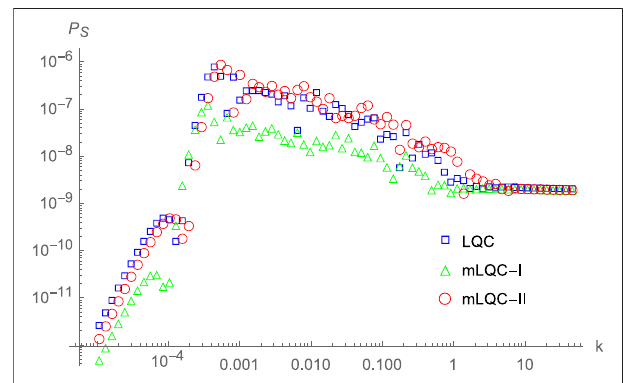
FIGURE 11 | The primordial power spectra of the cosmological scalar perturbations in the hybrid approach with the Starobinsky potential, respectively, for LQC, mLQC-I, and mLQC-II. The mass of the in fl aton fi eld is set to 2 . 44 × 10 − 6 m pl . The background evolution is chosen so that the pivot mode is k * (cid:2) 5 . 15 in all three models. The initial states are the second- orderadiabaticstatesimposed inthecontractingphaseatthemoment t 0 with t 0 ≪ t B (Li et al.,